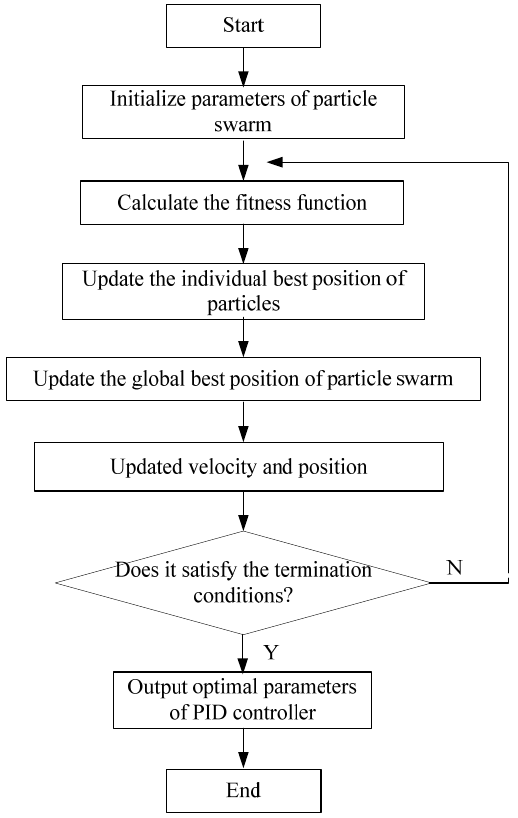
Figure B1. The flowchart of PSO algorithm tuning PID controller